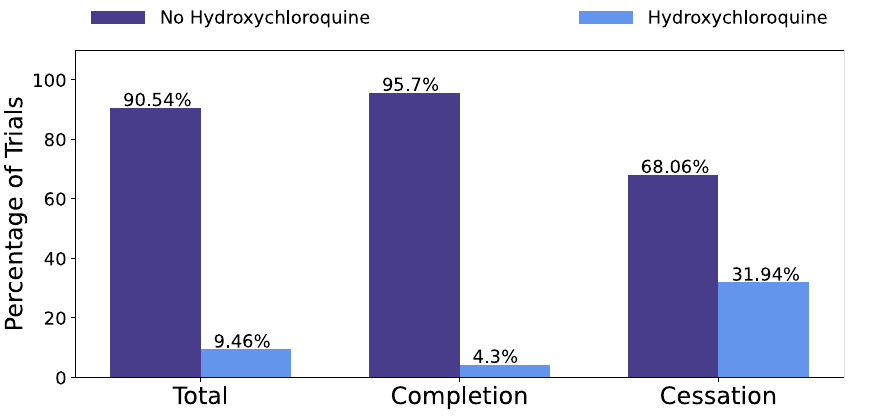
Fig 9. Distribution of trials that used Hydroxychloroquine as an